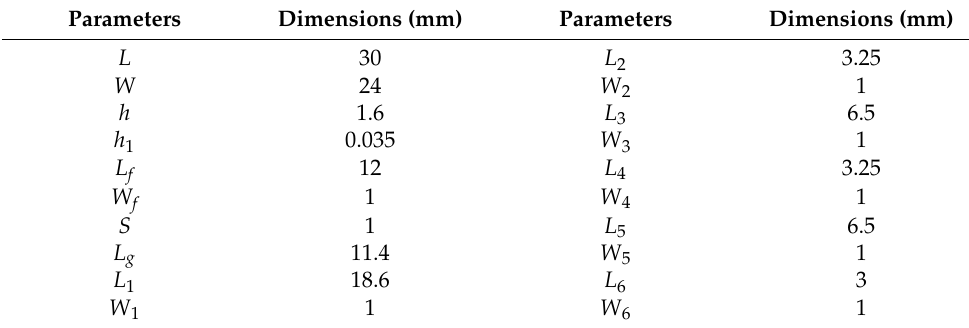
Table 1. Optimal dimensions of developed